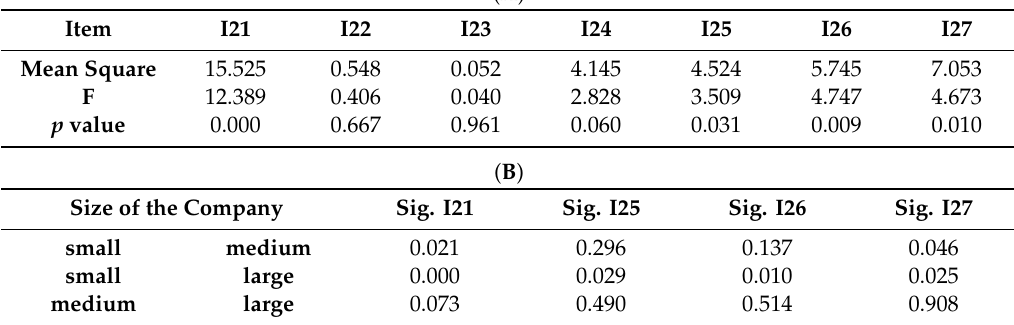
Table 10. ( A ) Significant di ff erences in talent assessment according to size of the company (ANOVA) and ( B ) Post hoc tests for significant di ff erences in talent assessment (Tukey